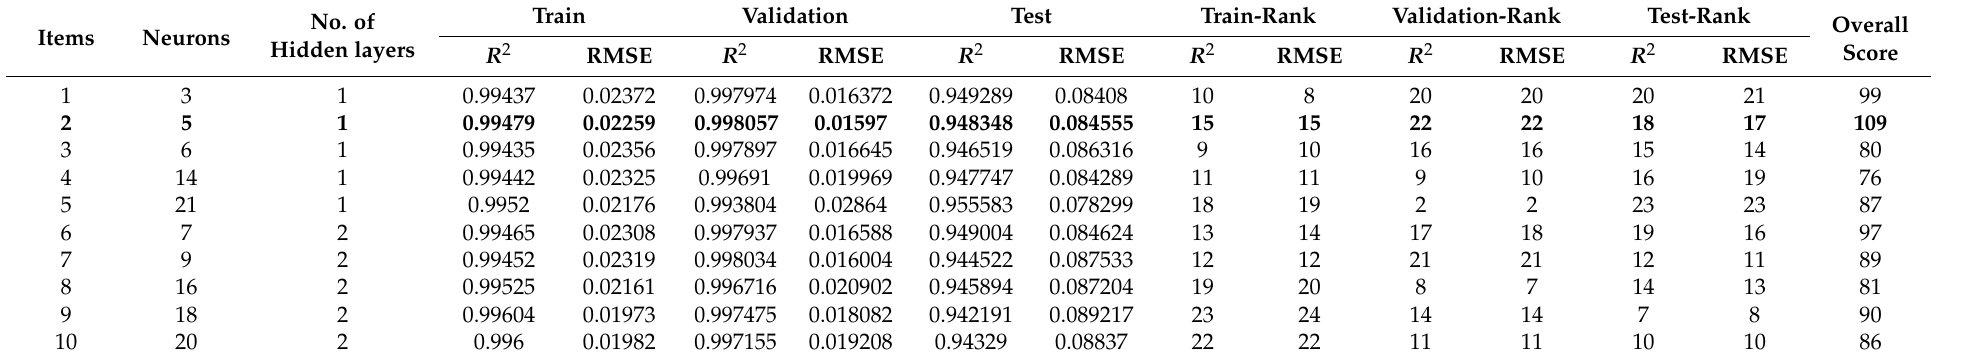
Table 7. Selecting the optimal ANN model with respect to hidden layers and neurons for the France dataset.